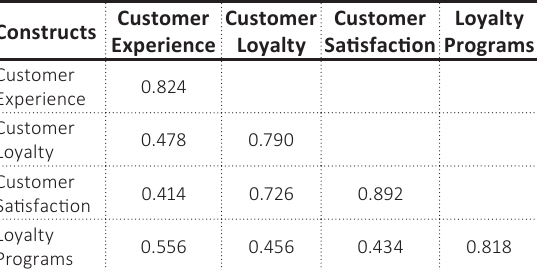
Table 3. Discriminant validity